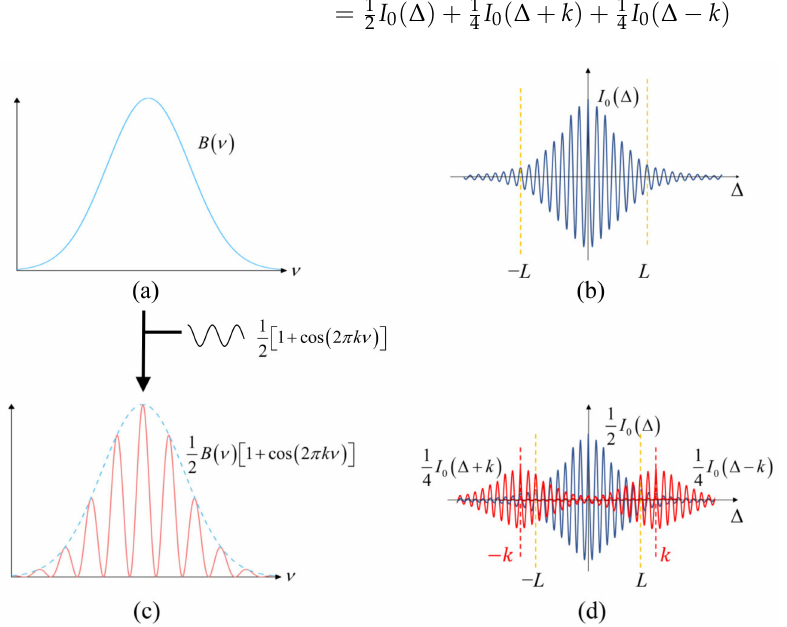
Figure 3. ( a ) The object spectrum; ( b ) the frequency spectrum of the object spectrum; ( c ) the spectrum after cosine modulation; ( d ) the frequency spectrum of the spectrum after modulation; the red curve represents the displacement